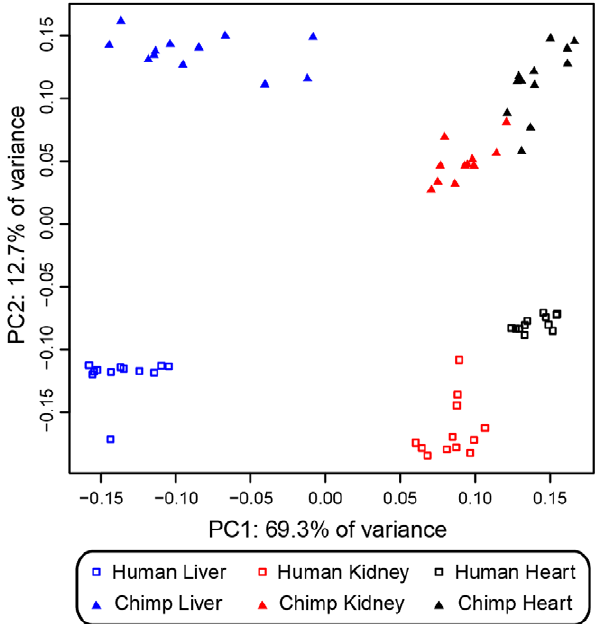
Figure 2. Principal components analysis of the methylation profiles. This analysis only considers the 9,911 autosomal CpG sites from all samples (PC1 and PC2 are plotted on the x-axis and y-axis, respectively).